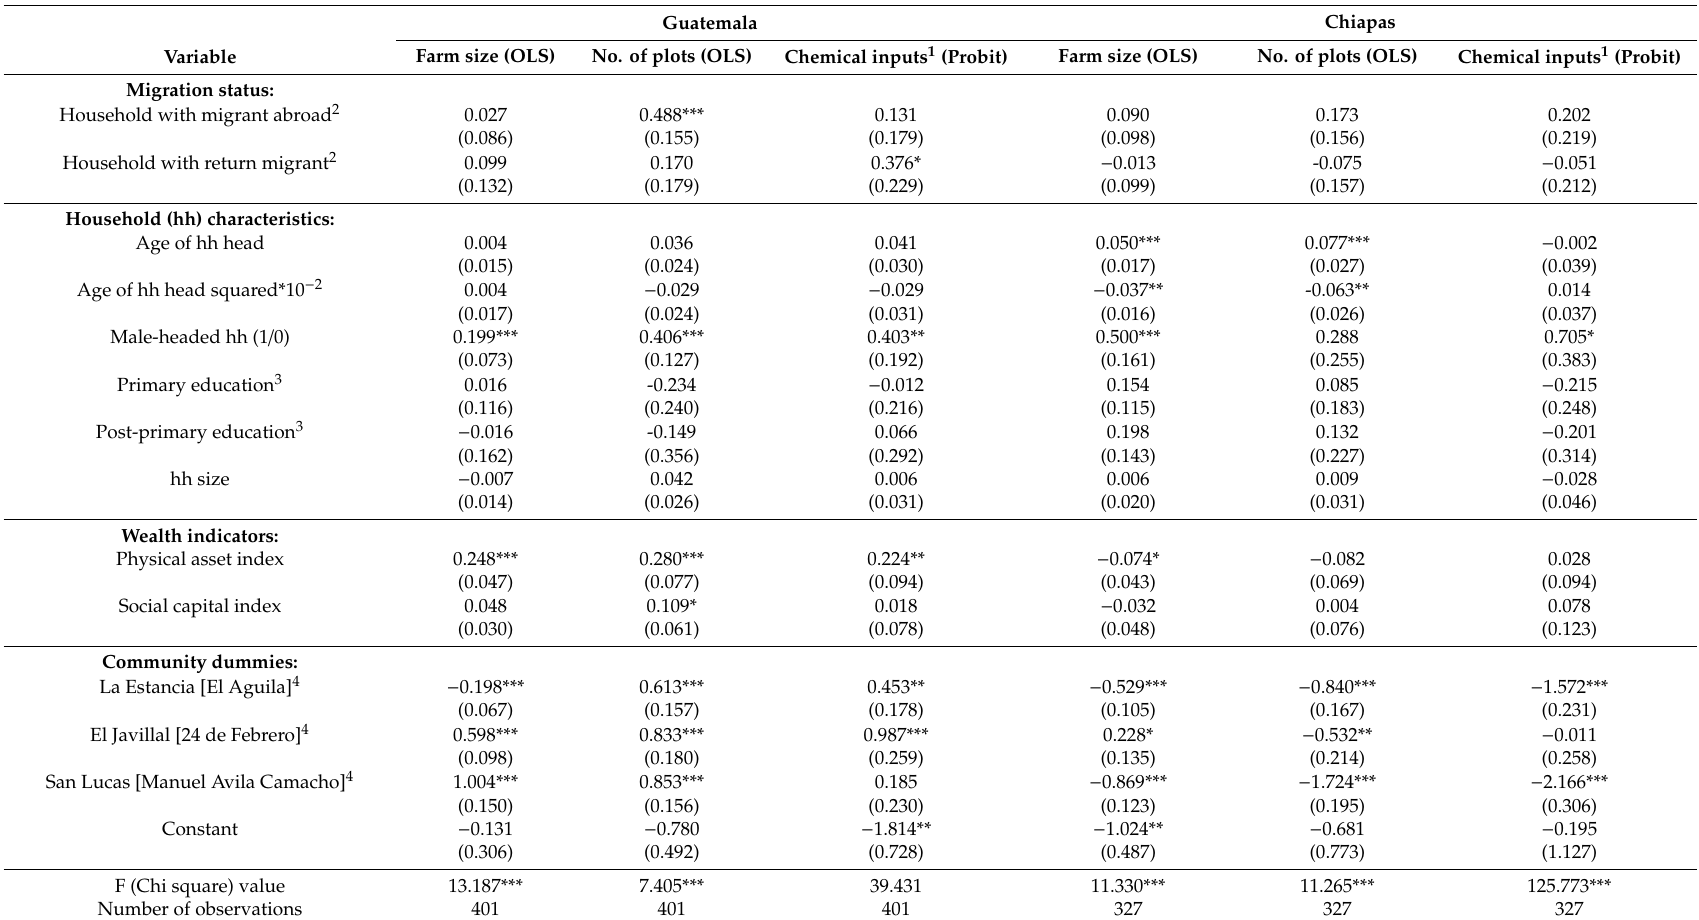
Table 4. Regression models for farm size, number of plots, and crop